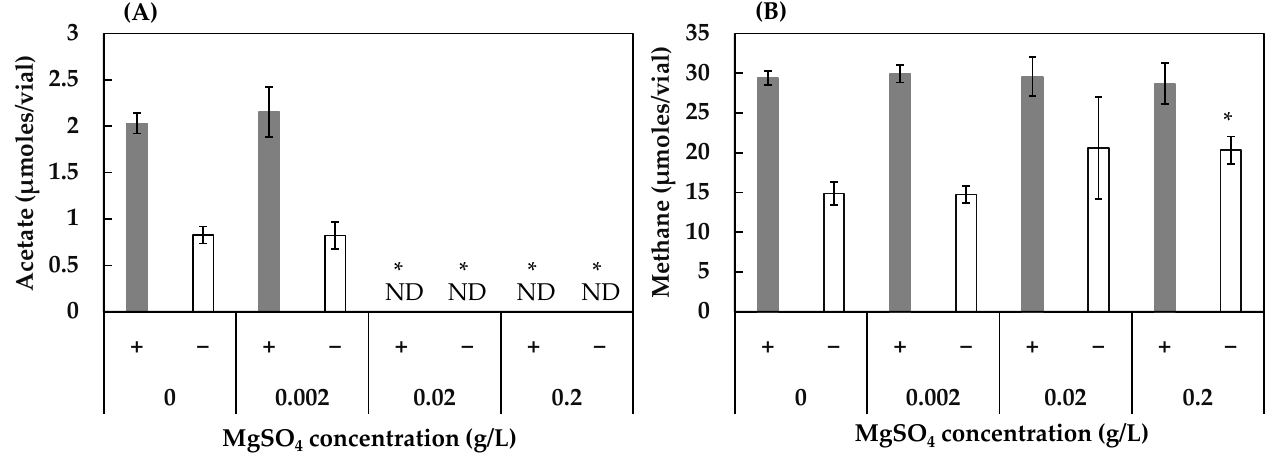
Figure 4. Effect of MgSO 4 concentration on the production of acetate ( A ) and methane ( B ) in the HL consortium in the presence (+) and absence (−) of humin. The conditions with 0 g/L of MgSO 4 are the same as the conditions 4 (with humin) and 2 (without humin) in Figure 1. Vertical bars represent the standard deviation. The acetate and methane production at various MgSO 4 concentrations were compared to those under the condition of 0 g/L of MgSO 4 using the independent t -test. * represents a significant difference at p < 0.05. ND: not